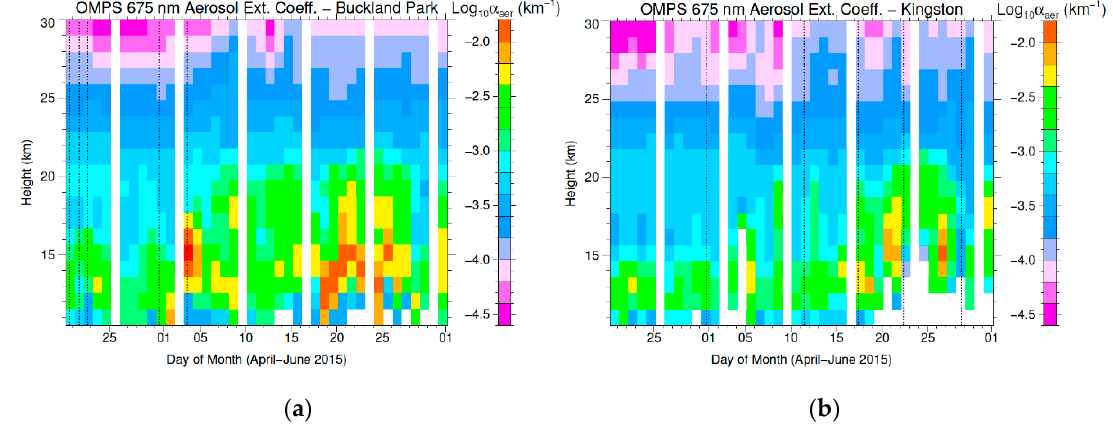
Figure 7. Base-10 logarithm of mean daily 675 nm aerosol extinction coefficient profiles from the Ozone Mapping Profiler Suite (OMPS) instrument obtained within 15° in longitude and 2° in latitude of ( a ) Buckland Park and ( b ) Kingston. The vertical dashed lines mark the mid-times of lidar measurements at each site. Regions of no available data are shown in white.